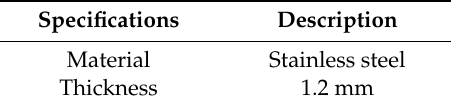
Table 2. Insulation specifications.